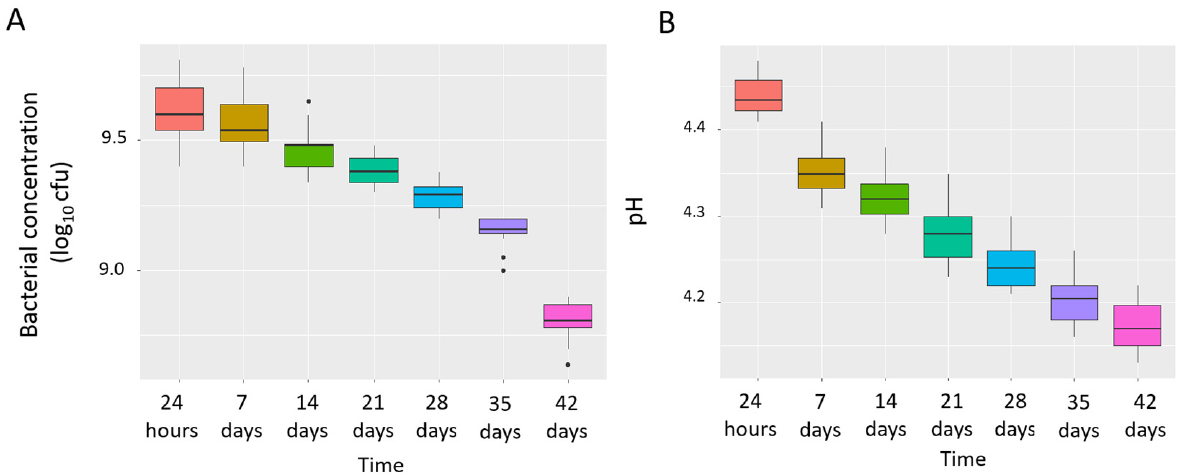
Figure 1. Box plots showing MRS bacterial concentration (log 10 CFU/container) ( A ) and pH ( B ) values of the dairy products over time. The boxes represent the values of the interquartile ranges, with the median represented as a line. Outliers are represented as dots.